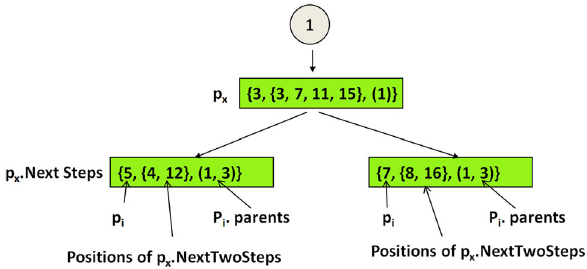
Fig. 8 Example for generating new NextSteps , containing p 5 and p 7 , where p